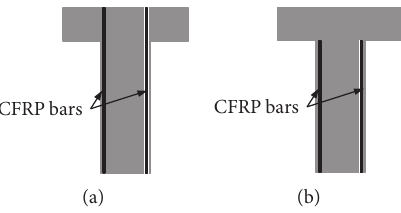
Figure 3: CFRP bars arrangements. (a) Anchorage in the flange. (b) On the side of the beam